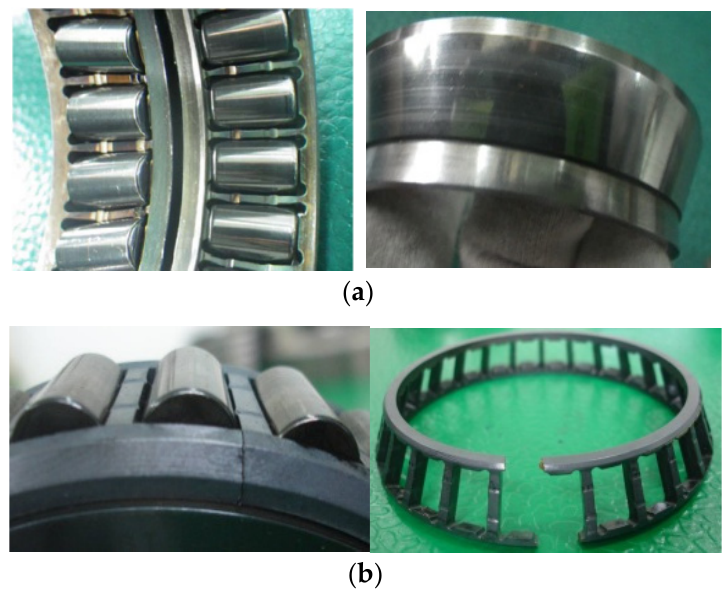
Figure 2. Disassembling inspection diagram after the bearing oil loss test. ( a ) Outer ring rib structure; ( b ) Inner ring rib structure.